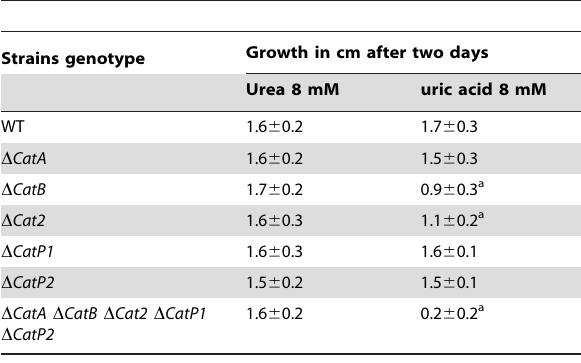
Table 1. Growth of the wild-type and catalase mutant strains on medium with different nitrogen source.